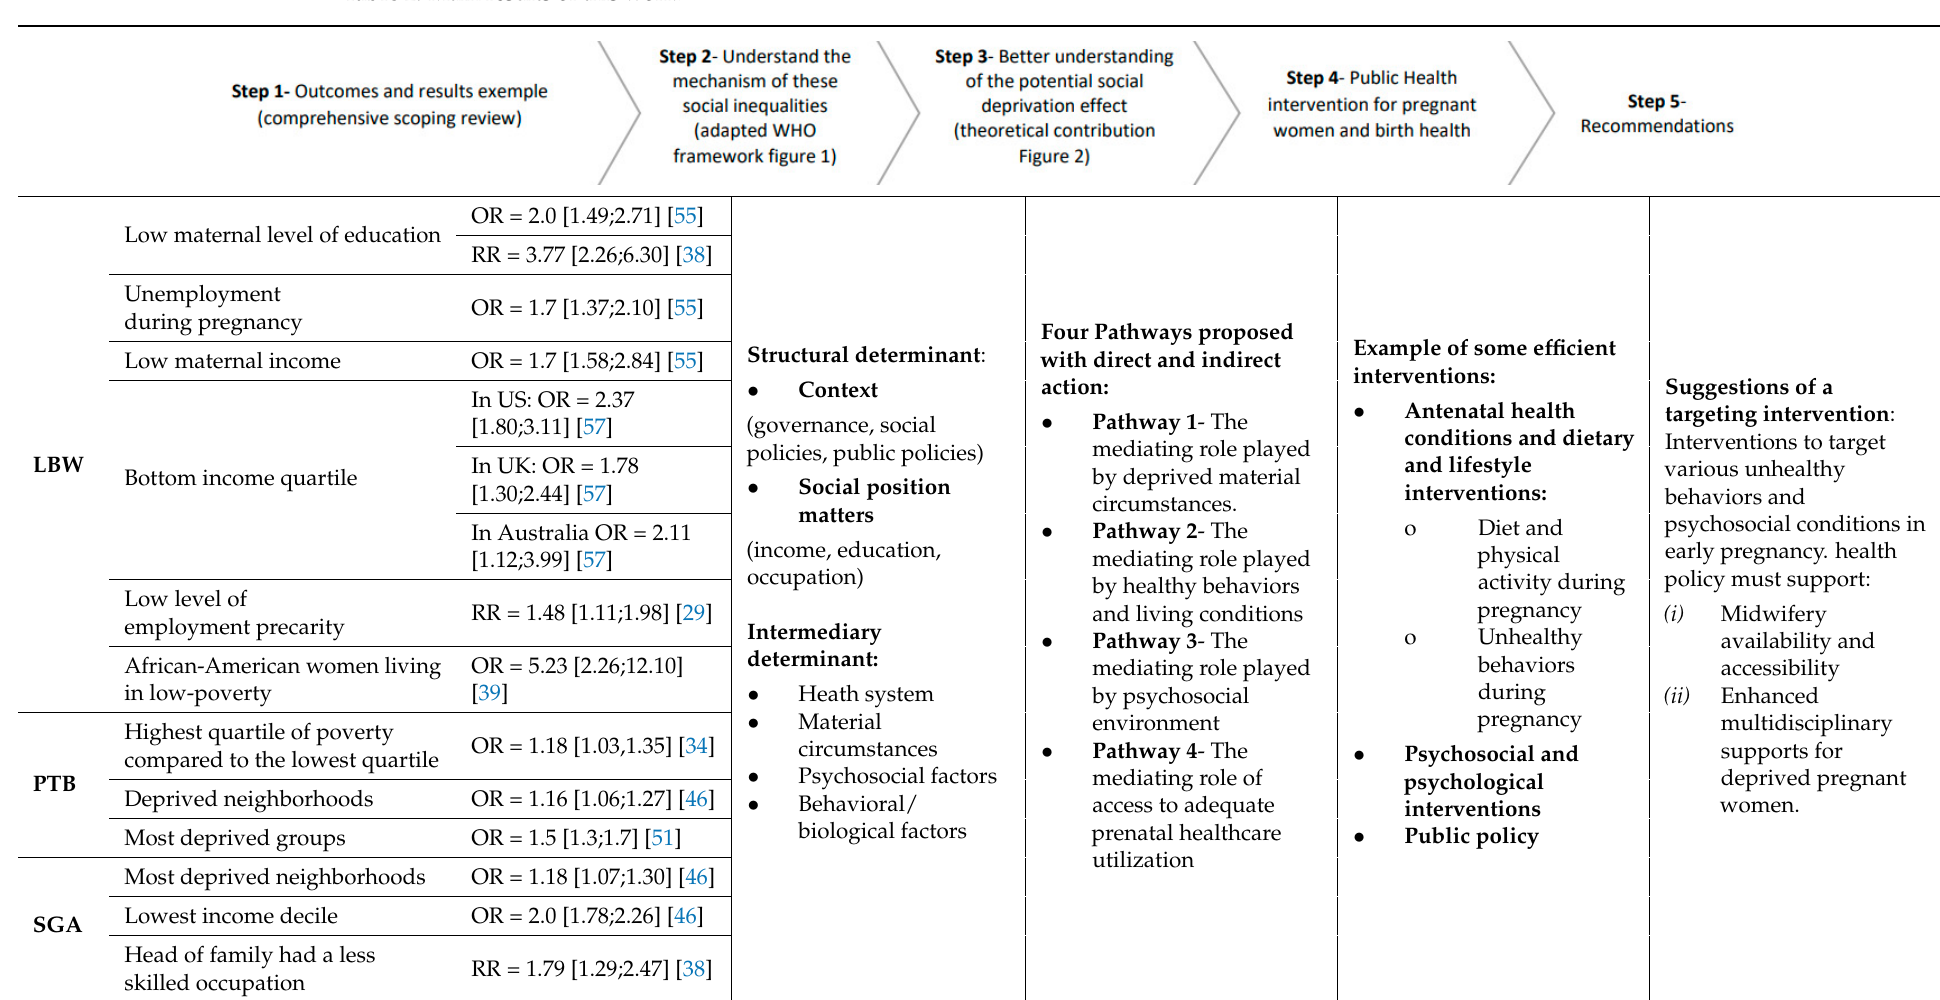
Table 2. Main results of this work.